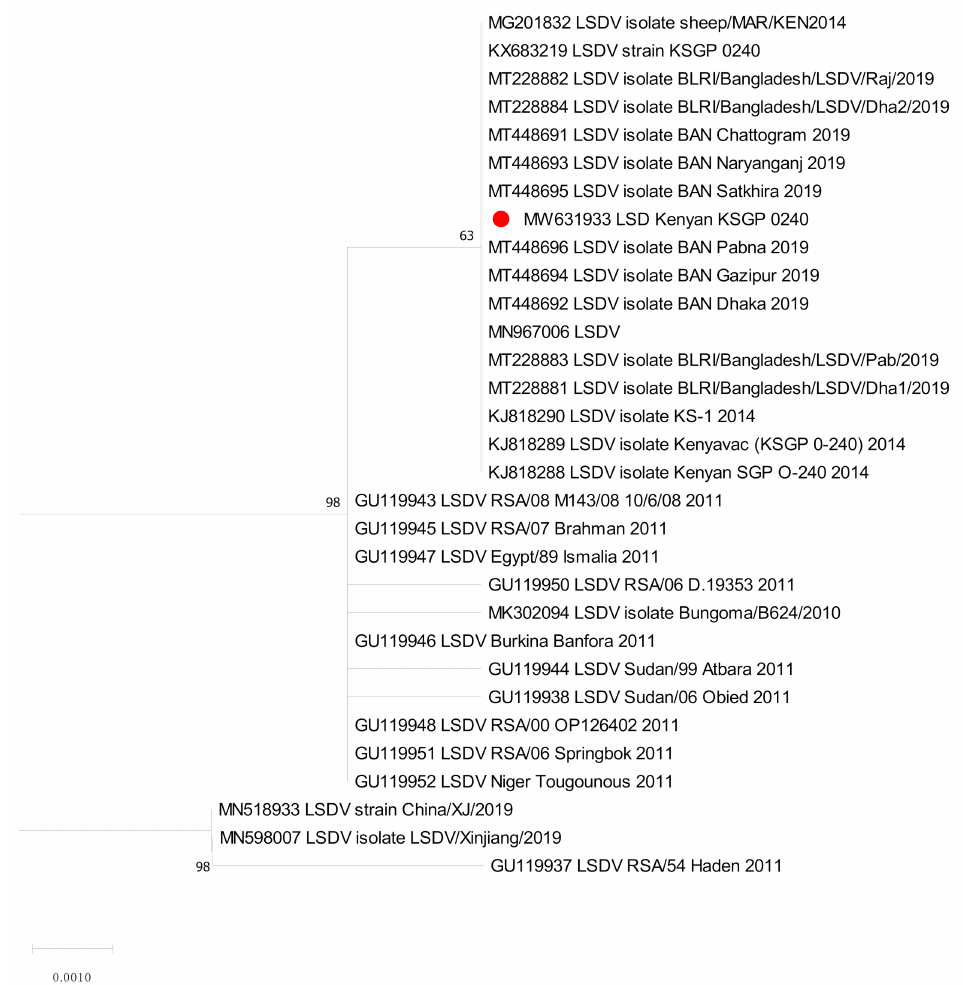
Figure 1. Molecular phylogenetic analysis of the Capripoxvirus RNA polymerase subunit gene (RPO30). The RPO30 sequence obtained in this study was marked with red circle shaped